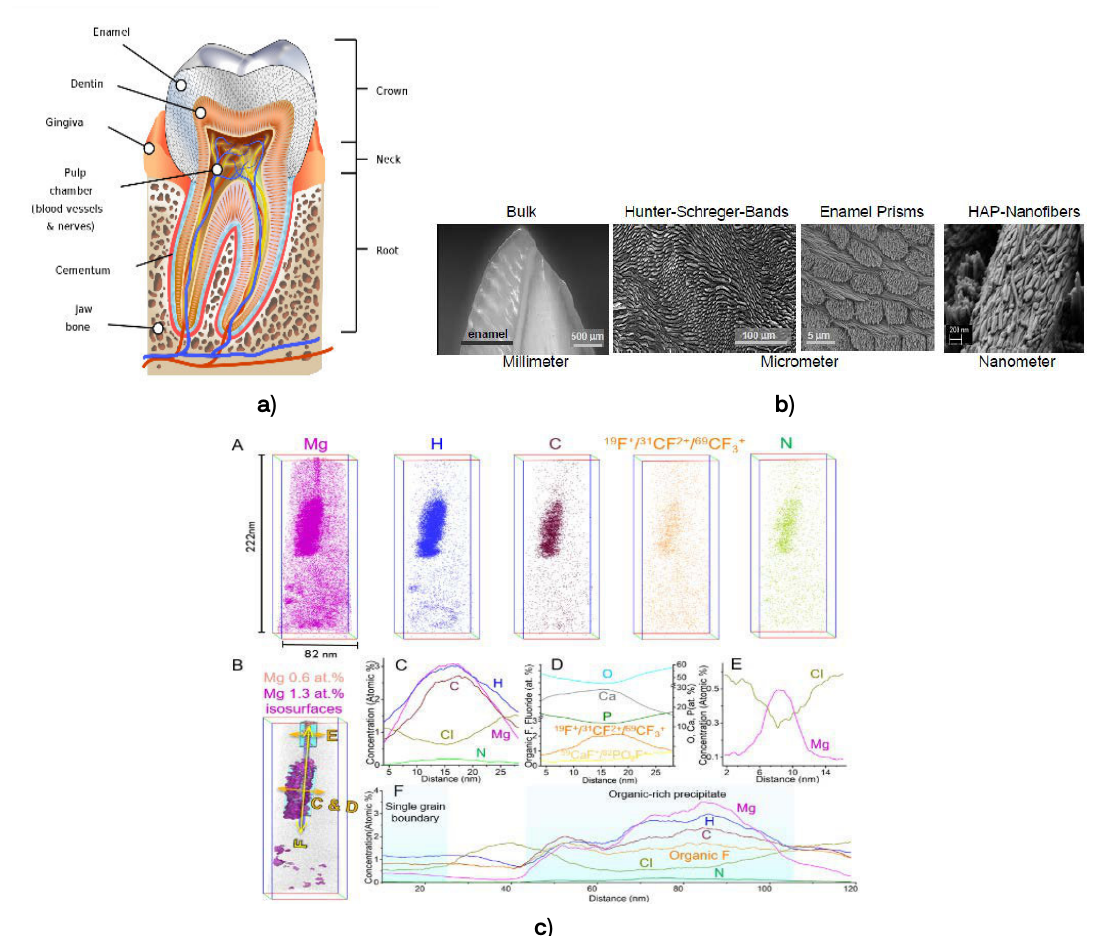
Figure 1. a) Over-view of the structure of teeth [39]. b) Hierarchical structure of enamel [42], and c) Atom